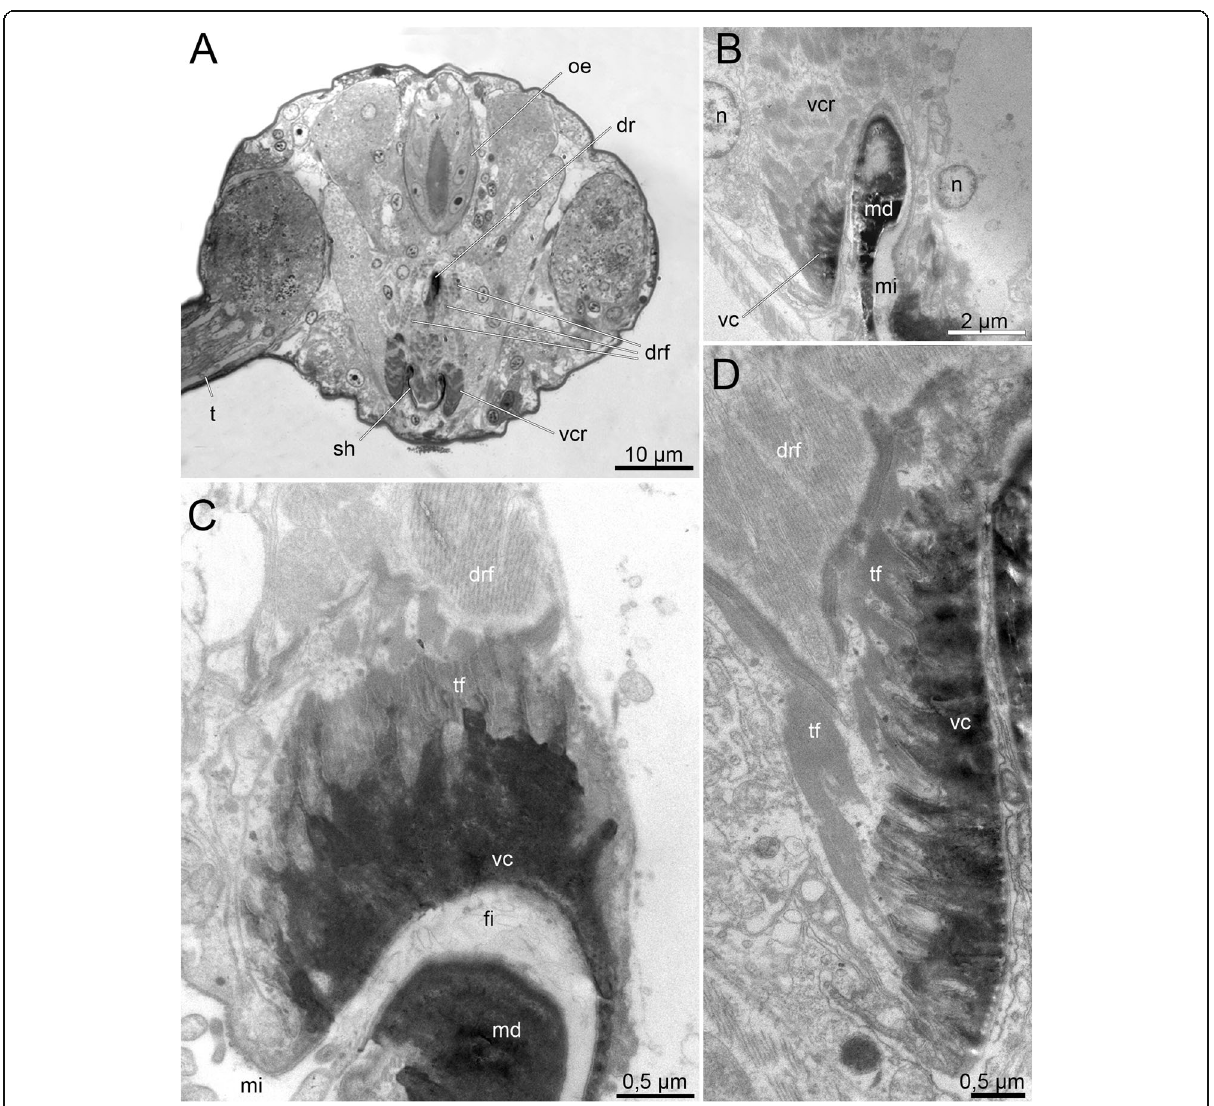
Fig. 10 Fine structure of the ventral carrier and mandibular shaft of Histriobdella homari . Transversal section through the median region of the adult mandibular shaft. Light microscopy ( a ) and TEM images ( b - d ). a . Semithin section through the ventral pharyngeal organ. b. General view of the ventral carriers and left mandibular shafts. c. Fine structure of the ventral carrier and dorsal portion of the right mandibular shaft (note the structure between the ventral carrier and the mandible). d . Fine structure of the left ventral carrier. dr, dorsal rod; drf, dorsal rod flexor; fi, fibrous- like substance; md, mandible; mi, median VPO invagination; n, nucleus; oe, esophagus; sh, mandibular shaft; t, tentacle; tf, tonofilaments; vc, ventral carrier; vcr, ventral carrier